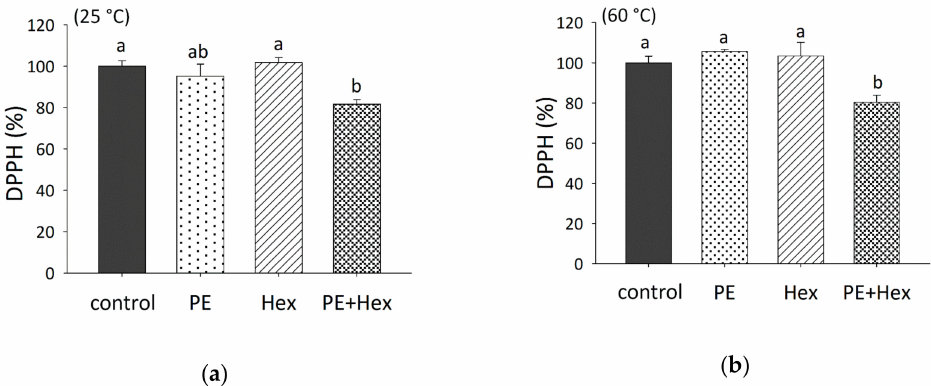
Figure 4. Free radical scavenging activity of PE (16:0 / 18:1) (0.5 mM) and / or hexanal (1 mM) as determined by the 2,2-diphenyl-1-picrylhydrazyl (DPPH) assay in toluene. Samples and control, which consisted of chloroform-methanol (2:1), were pre-treated for 60 min either at 25 ( a ) or 60 ◦ C ( b ), followed by incubation with DPPH for 60 min. The DPPH absorbance (520 nm) in the samples ( n = 3) was compared to the control, which was set to 100%. Each experiment was performed thrice. Di ff erent letters indicate significant di ff erences. Statistical analysis was performed by applying one-way ANOVA with the Holm–Sidak post hoc